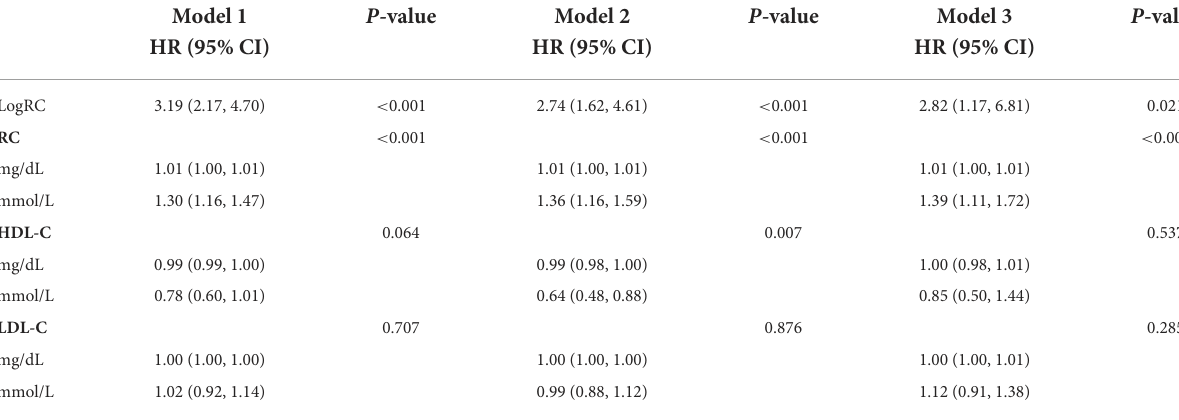
TABLE 2 Cox models for cardiovascular mortality for logRC, RC, HDL-C, LDL-C (continuous variables) in the pooled cohort. Model 1